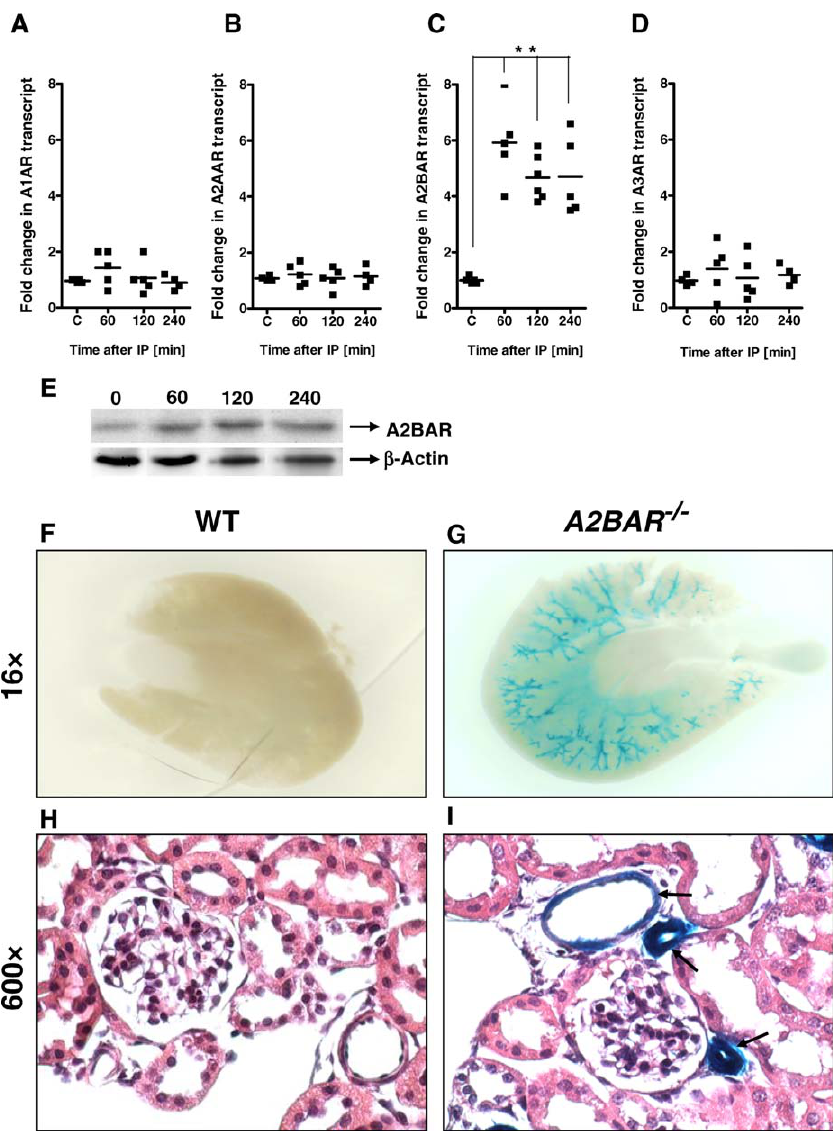
Figure 9. Transcriptional Responses to Renal IP and Expression of the A2BAR within the Kidneys (A–D) Age-, gender-, and weight-matched C57BL/6J mice were subjected to right nephrectomy followed by in situ IP with a hanging weight system for atraumatic occlusion of the left renal artery. The IP protocol consisted of four cycles of ischemia/reperfusion (4 min each), followed by indicated times of reperfusion. Transcriptional responses of the A1AR, A2AAR, and A2BAR of the A3AR were assessed by real-time RT-PCR. Data were calculated relative to b -actin and are expressed as fold change compared to sham-operated animals without IP treatment. (E) Western blotting for renal A2BAR following IP treatment. Kidneys were excised at indicated times, flash frozen, and lysed; proteins were resolved by SDS PAGE and transferred to nitrocellulose. Membranes were probed with anti-A2BAR antibody. The same blot was reprobed for b -actin as a control for protein loading. One representative experiment of three is shown. (F–I) A previously described A2BAR reporter mouse was used (A2BAR-KO/ b -gal–knock-in mice). Renal tissues were prepared and stained for b - galactosidase ( b -Gal) as indicative of the A2BAR gene promoter, which drives the expression of this reporter gene. Procedures are as detailed under Methods. (F, G) b -Gal staining of kidney derived from littermate controls (WT) or A2BAR (cid:2) / (cid:2) mice, and captured at the indicated magnifications (16 3 ) with an Olympus IX70 microscope combined with Hamamatsu charge-coupled device camera C4742–95. (H, I) HE-staining histological examination of renal sections derived from the kidney shown in upper panel. Arrows point to b -Gal stained blood vessels. Fold magnification of captured images are 600 3 . WT mice were subjected to similar staining showing no expression. b -Gal expression in kidney is clear and localized only in blood